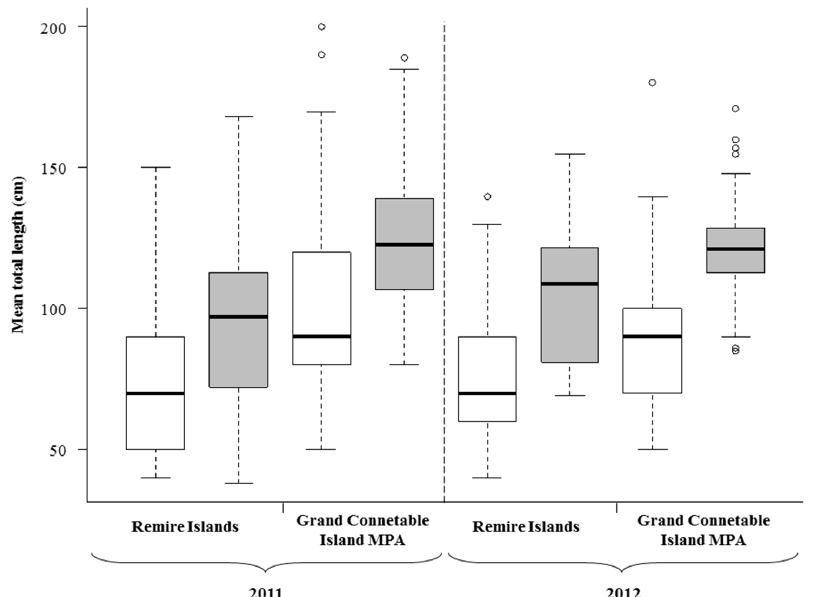
Figure 5. Mean total length (cm) of goliath groupers ( Epinephelus itajara ) estimated with a P900-130 BlueView acoustic camera (white box) and measured during fishing trips (gray box) around rocky islands of French Guiana in 2011 and 2012.